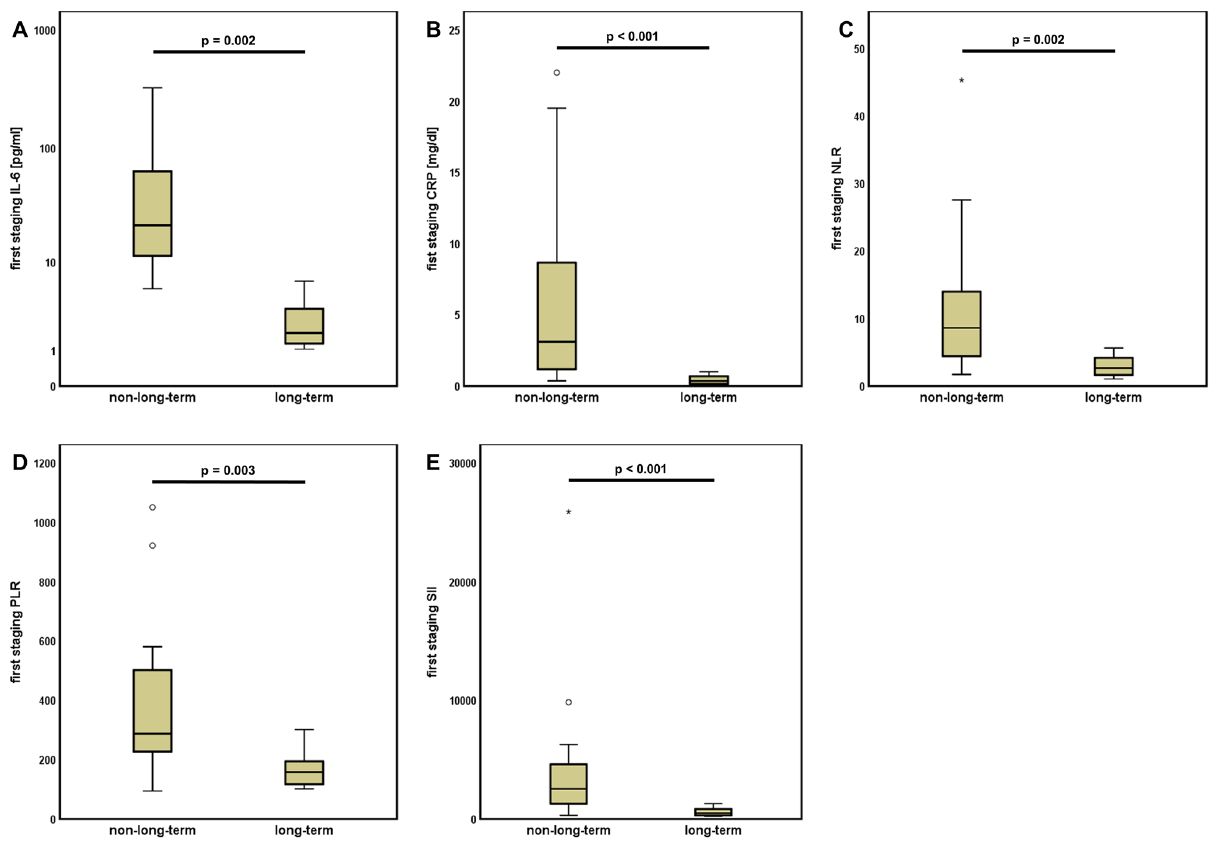
Figure 4. First staging inflammatory scores and cytokine levels predict long-term response to ICI. At the time of the first staging, patients with long-term response showed significantly lower levels of ( A ) interleukin 6 (IL-6), ( B ) CRP and ( C ) neutrophil to lymphocyte ratio (NLR), ( D ) platelet to lymphocyte ratio (PLR) and ( E ) systemic inflammation index